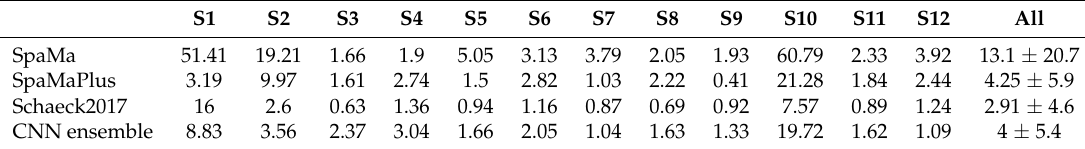
Table 7. Session-wise evaluation results on the dataset IEEE_Training , achieved with the three classical methods and the best performing CNN architecture (ensemble prediction). Results are given as MAE [bpm].